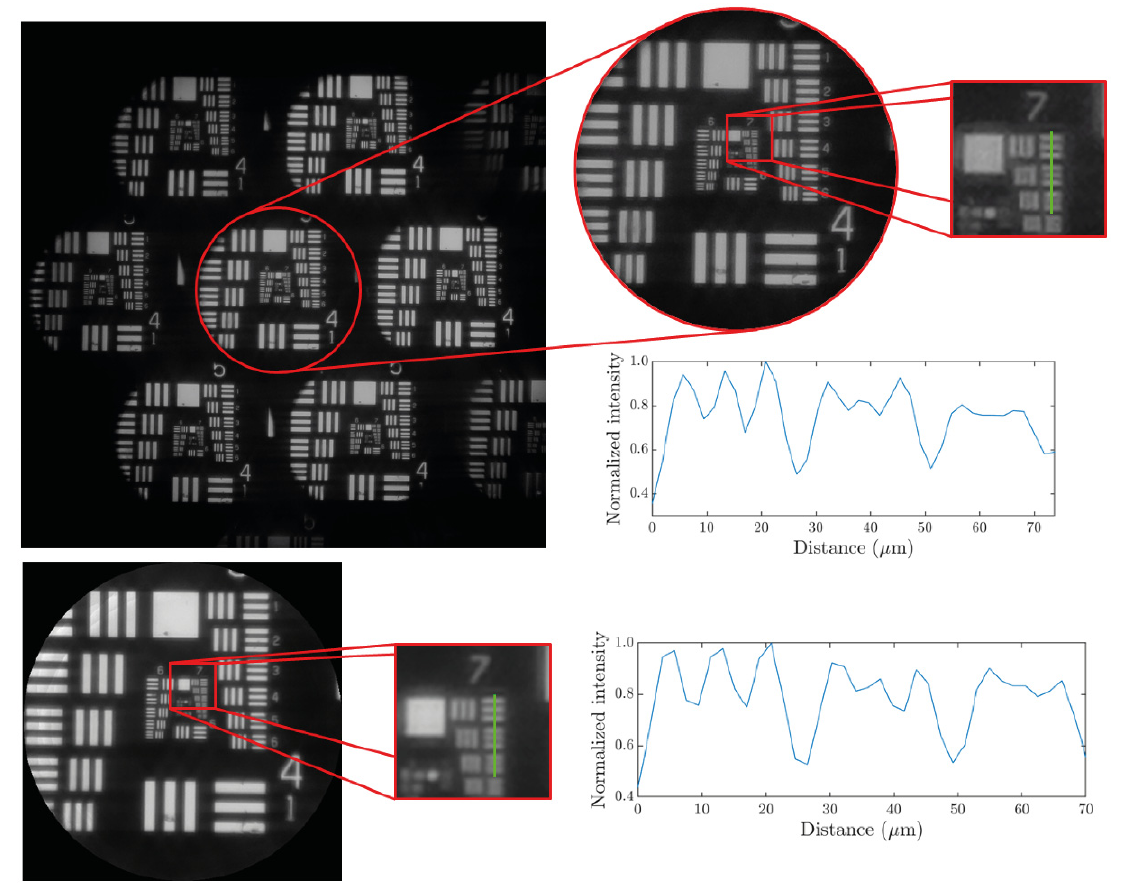
Figure 3. Study of the spatial resolution of the handheld and cost-effective FLMic. In the upper row, the lateral resolution of the central image is studied and in the lower row that of the refocused image at the best focus plane.